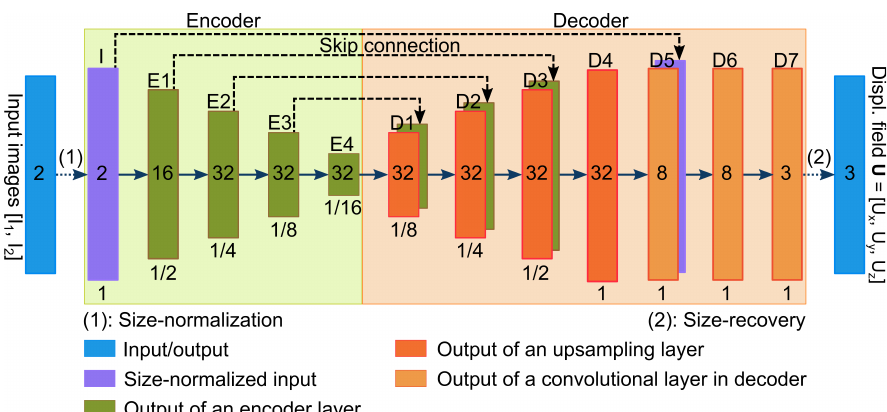
Figure 2. The convolutional encoder–decoder for mapping a pair of reversed-PE images to the 3D displacement field. Box : output feature maps of a layer. Number inside each box : number of feature maps in the layer. Number below each box : feature map size relative to the full input image